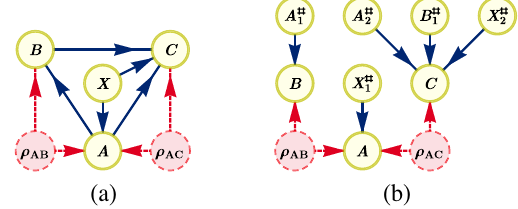
FIG. 7. An example causal structure (a) and its maximal inter- ruption (b). Note that in (a) the observable nodes A and B both possess at least one parent node as well as at least one child node. Additionally, the observable nodes A and X have multiple child nodes. Constraints on distributions extended to the inter- rupted graph (such as those obtained via quantum inflation) are translated into constraints on the original distribution using the postselection relation P 7 ð A ¼ a;B ¼ b;C ¼ c j X ¼ x Þ ¼ ð a Þ P A ¼ a;B ¼ b;C ¼ c j X # X # x;A # A # a;B # b Þ . 7 ð b Þ ð 1 ¼ 2 ¼ 1 ¼ 2 ¼ 1 ¼ The maximally interrupted DAG in (b) has the two-layer network structure considered in Sec.